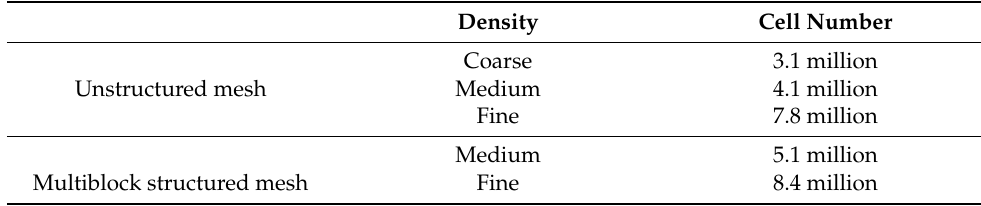
Table 4. Mesh size